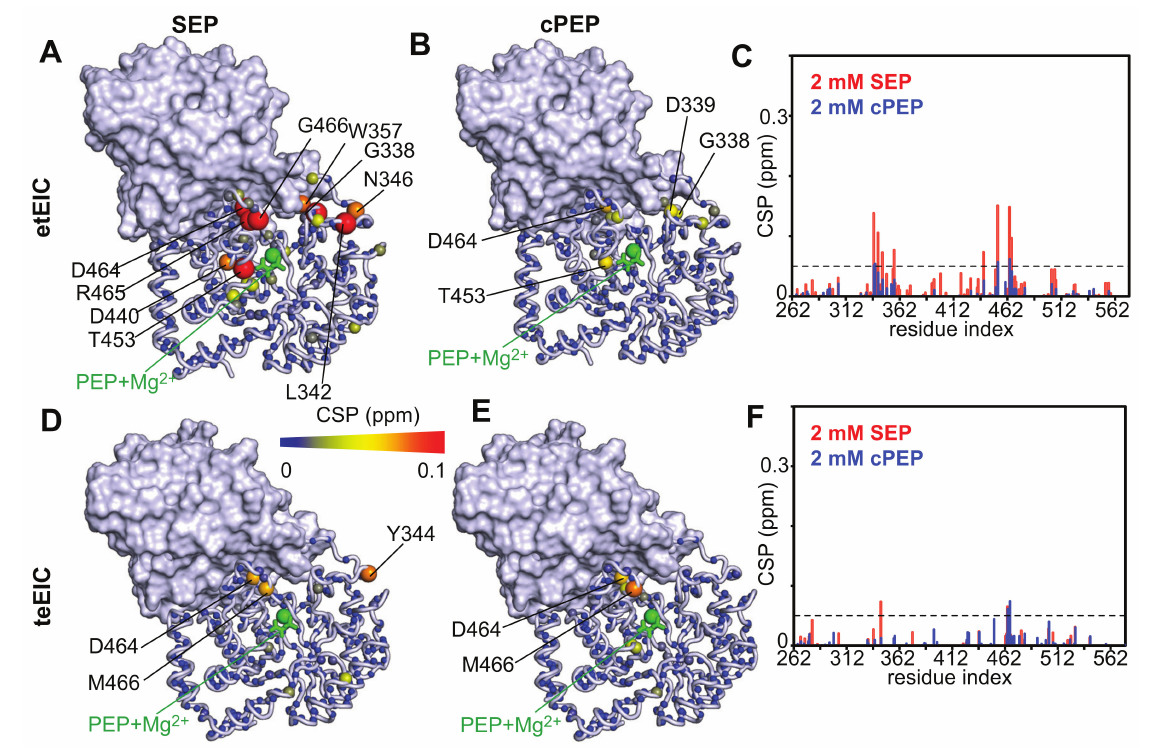
Figure 5. The weighted combined chemical shift perturbations (CSP) induced by ( A ) 2 mM SEP and ( B ) 2 mM cPEP on the 1 H- 15 N TROSY spectrum of etEIC are displayed on the structure of the EIC–PEP complex as spheres with the relationship between size and color of each sphere and the CSP depicted by the color bar. CSPs are shown on one subunit of the EIC dimer. The second subunit is shown as gray surface. PEP and the Mg 2+ ion are shown as green sticks and sphere, respectively. ( C ) Bar graph showing the CSPs induced by SEP (red) and cPEP (blue) on etEIC. The dashed line is at CSP = 0.05 ppm. The CSP induced by ( D ) 2 mM SEP and ( E ) 2 mM cPEP on the 1 H- 15 N TROSY spectrum of teEIC are displayed on the structure of the EIC–PEP complex. ( F ) Bar graph showing the CSPs induced by SEP (red) and cPEP (blue) on